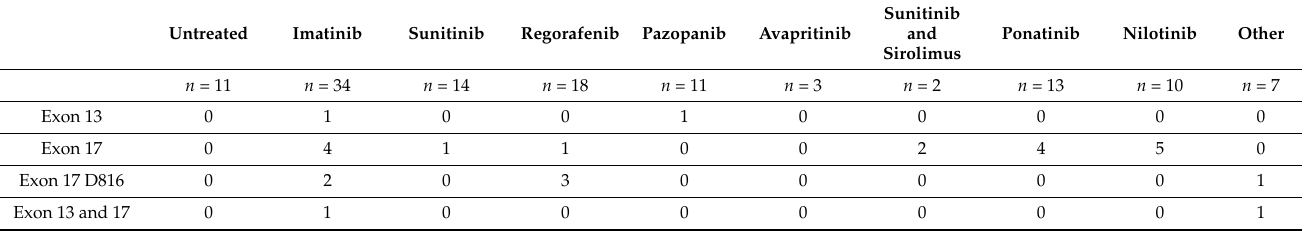
Table 3. Detection of resistance mutations subdivided by TKI. Expected resistance is shown by color (red: resistant, yellow: intermediate, green: sensitive, grey: unknown).